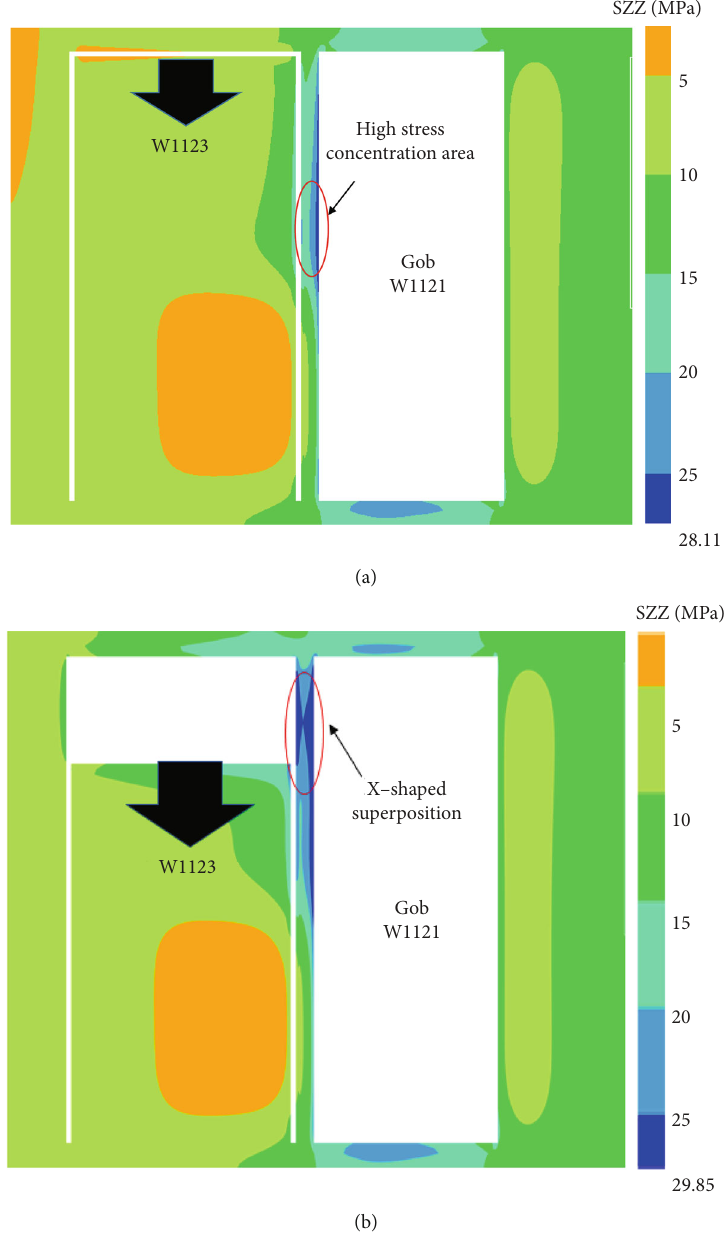
Figure 5: Vertical stress distribution of coal pillar: (a) advancing 0m and (b) advancing